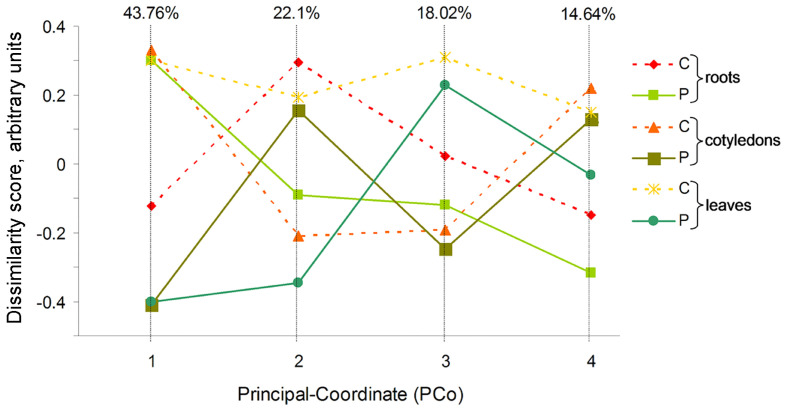
Variability within the data set of 16S rRNA metagenomic analysis projected in a set of four uncorrelated axes of the principal coordinate analysis (PCoA) carried out using Bray-Curtis dissimilarity index. Proportion of variance for each dimension is indicated on top. For each axis, objects ordinated closer to one another are more similar than those ordinated further away.